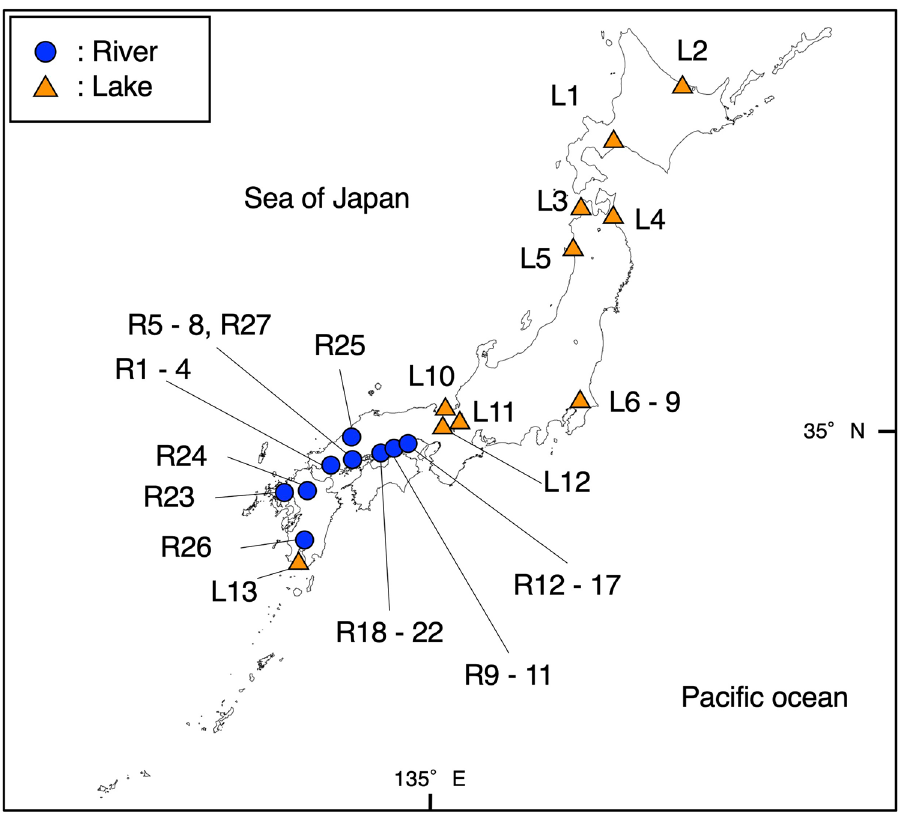
Figure 4. Sampling sites used in the present study. Blue circles and orange triangles show the locations of the river and lake samples, respectively. Detailed information on each site is listed in Supplementary Table S1. This map has been illustrated using QGIS ver.3.10 (http:// www. qgis. org/ en/ site/) based on the Administrative Zones Data (http:// nlftp. mlit. go. jp/ ksj/ gml/ datal ist/ KsjTm plt- N03- v2_3. html) which were obtained from free download service of the National Land Numerical Information (http:// nlftp. mlit. go. jp/ ksj/ index. html, edited by RN). There was no need of obtaining permissions for editing and publishing of map